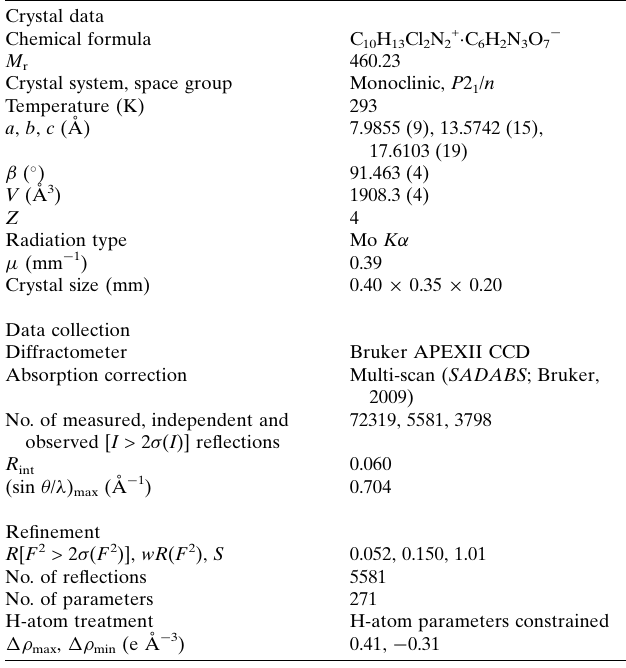
Crystal data Chemical